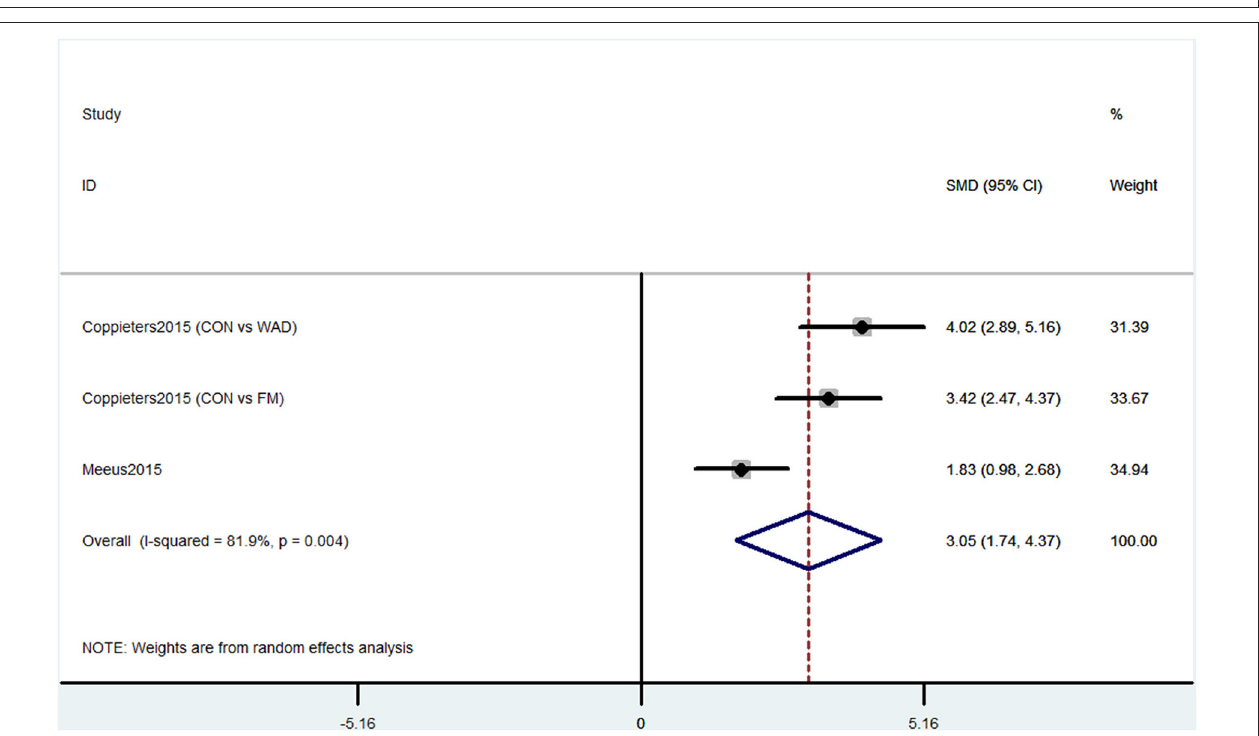
FIGURE 3 | Forest plot of the SMD and 95% CI from a random-effects meta-analysis for the association between chronic pain and incidence of cognitive decline when MOCA was used. The rhombi represent the pooled SMD for this association.